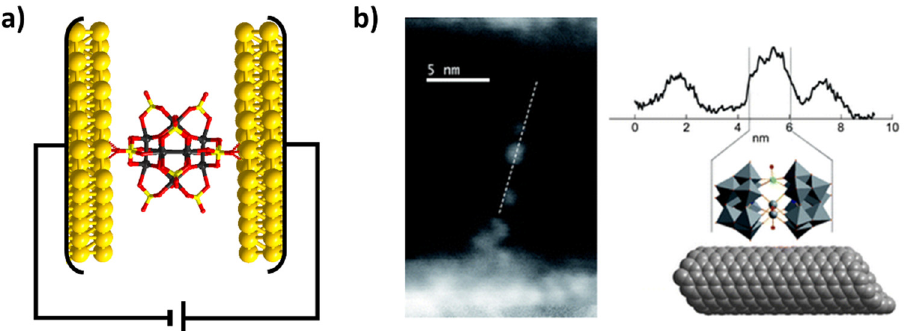
Figure 18. ( a ) Current-switching POMtronics based on {Pt 12 O 8 (SO 4 ) 12 } polyanions sandwiched between two gold electrodes as reported in refence [126]. ( b ) High-angular annular dark-field scanning transmission electron microscopy image of {Co(H 2 O)(WO) 2 (AsW 9 O 33 ) 2 } deposited over carbon nanotubes. Reproduced with permission from reference [127] published by The Royal Society of